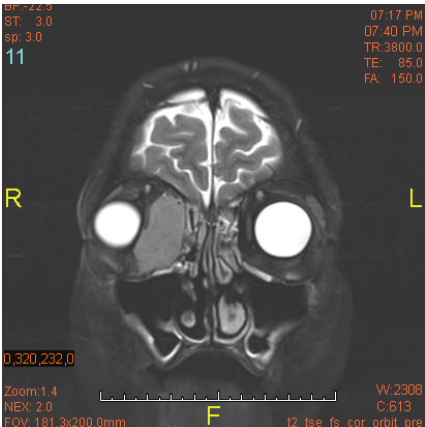
Figure 1: Orbits MRI. Right orbit: there is a 4.1 × 1.9 × 3.5 cm mass in the medial aspect of the right orbit. The mass displaces the medial rectus laterally and the globe anteriorly and laterally. The optic chiasm is normal in appearance. There is no suprasellar or parasellar mass. The pituitary gland is within normal limits in size.